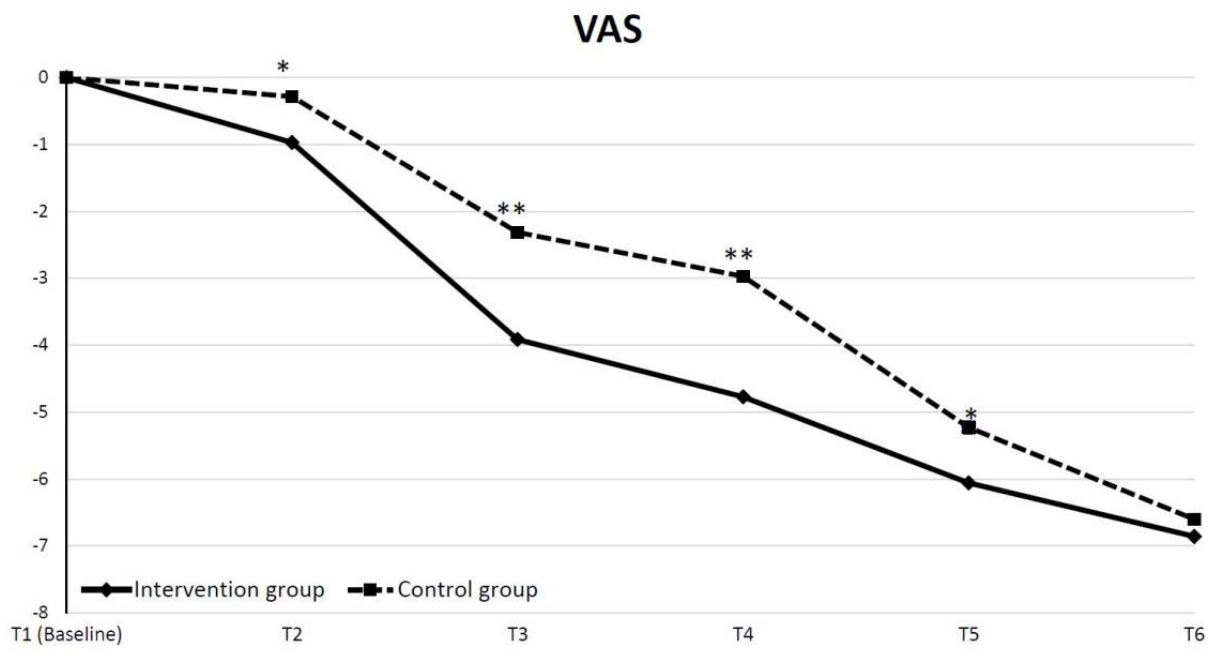
Figure 2. Time course of mean change in pain intensity from baseline to each checked time point (* p < 0.05, ** p < 0.01.